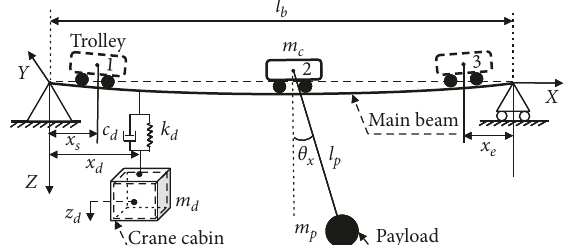
Figure 6: Physical model of crane vibration due to a moving